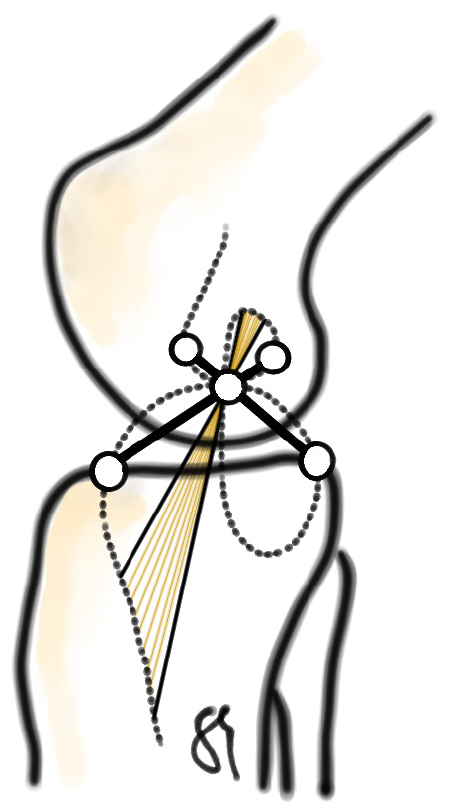
Figure 1. According to Burmester, fibres and insertion points of the collateral ligaments correspond to two-third-order curves, which are related to the articular surface and intersect at the crossing point of the four-bar linkage. This guarantees tensioned ligamentous fibres throughout flexion.